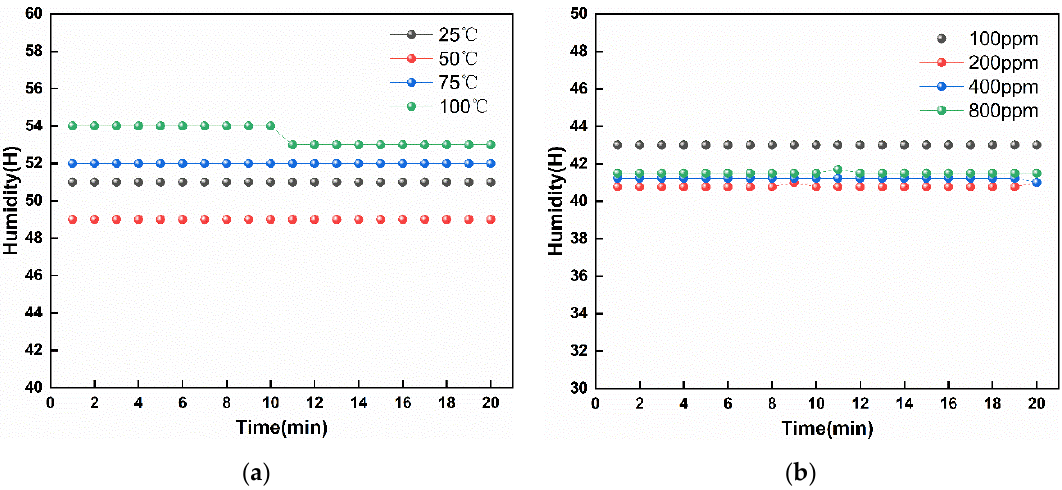
Figure 5. Humidity response of the sensor. ( a ) Response of sensor humidity over time in different temperature environments. ( b ) Response of sensor humidity over time in environments with different NH 3 gas concentrations.